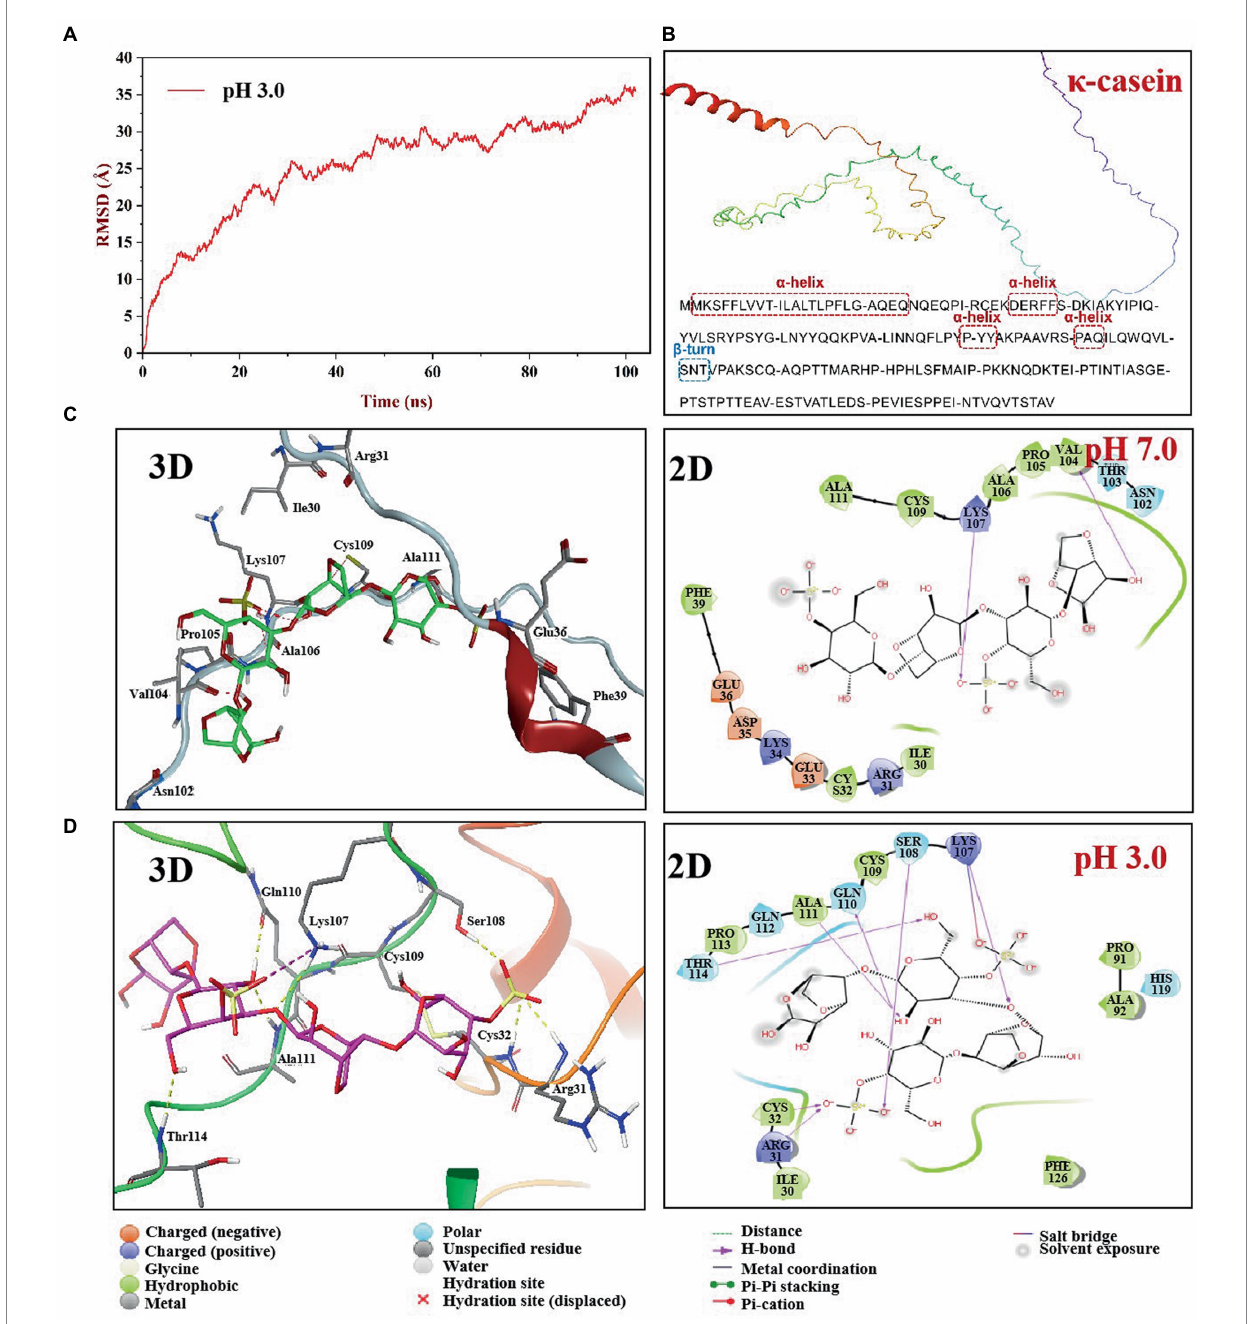
FIGURE 6 Molecular dynamics simulation of κ -CGN and κ -casein in two pH boxes. The root means square deviation (RMSD) of κ -CGN interaction with κ -casein as a function of simulated times at pH 3.0 condition (A) ; The 3D structure of bovine κ -casein was automatically figured out by the AlphaFold2 software (B) ; 3D and 2D interaction plot of κ -CGN and κ -casein at pH 7.0 (C) and pH 3.0 (D) .